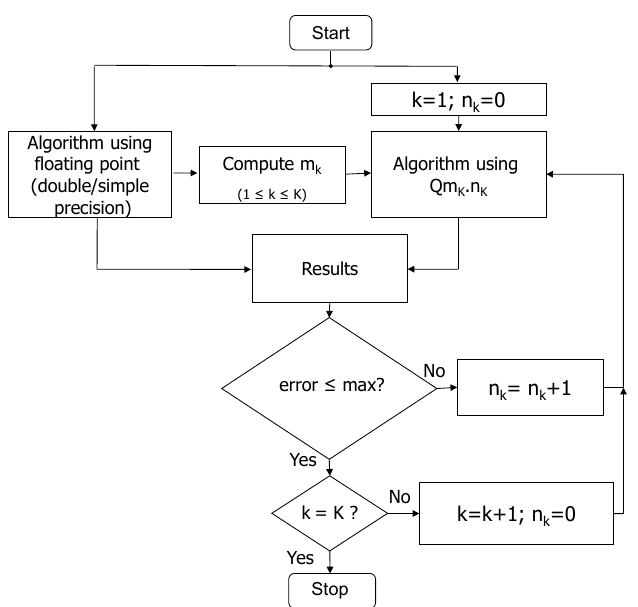
Figure 3. Methodology used to adjust the fixed-point formats on MATLAB.